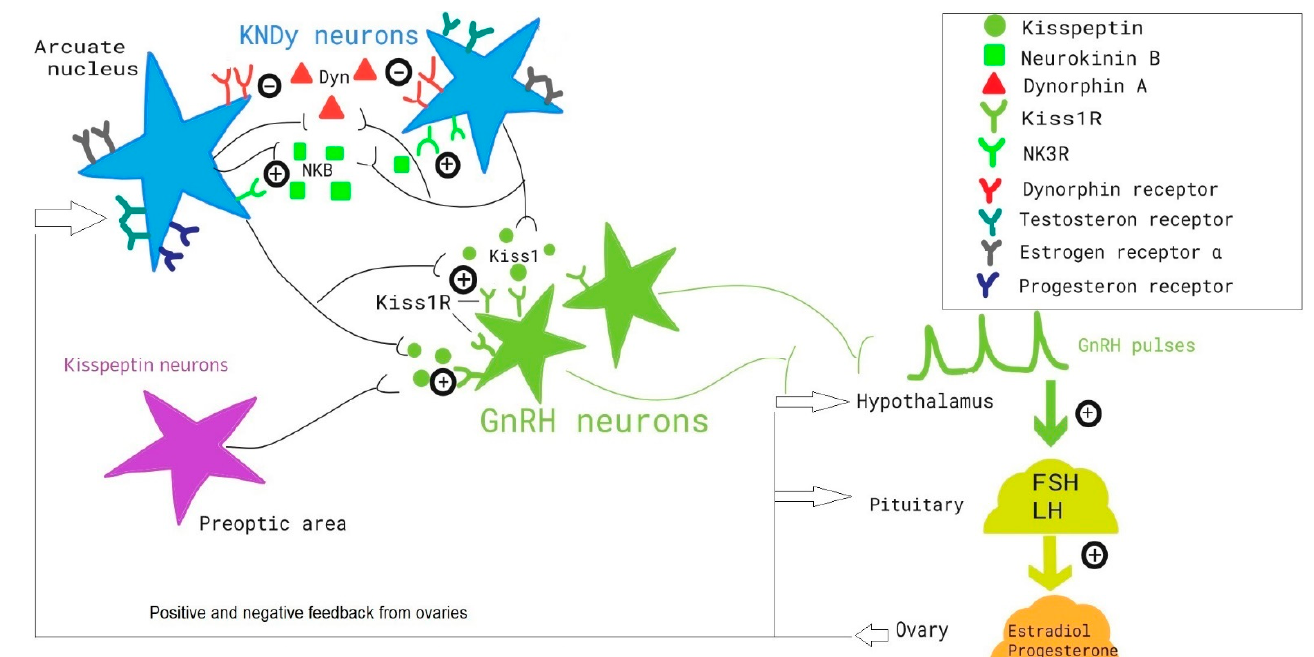
Figure 1. Schematic representation of the role of KNDy neurons in the regulation of the hypothalamic–pituitary–ovarians axis.